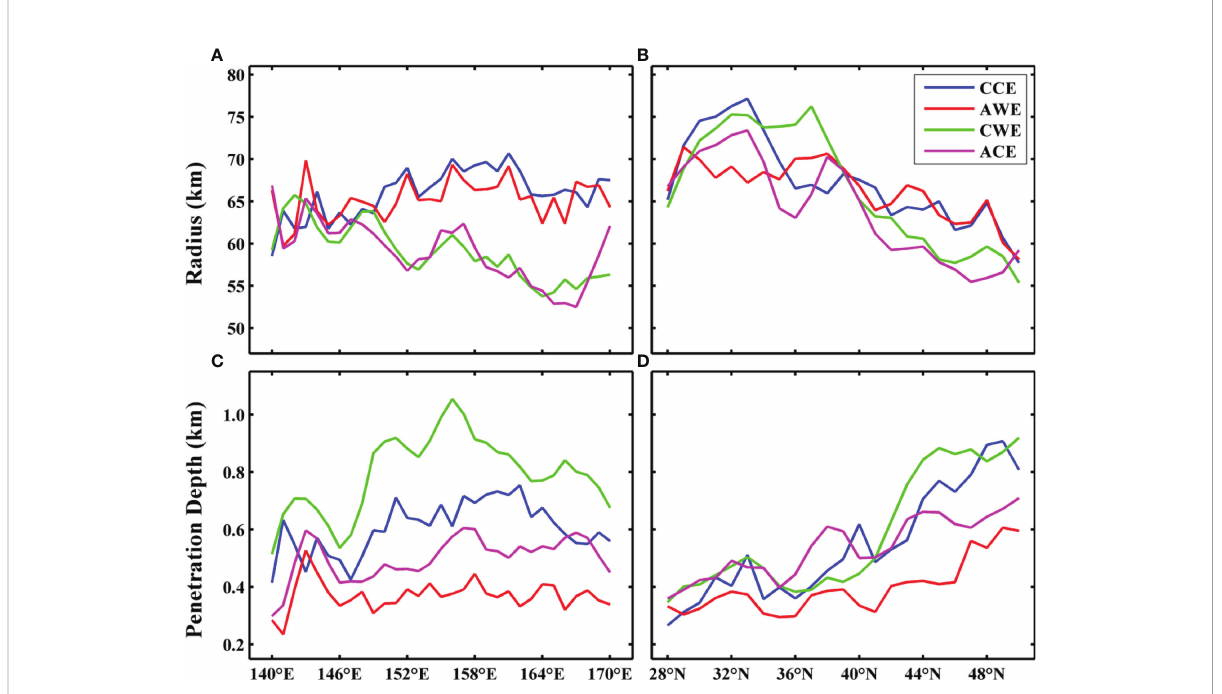
FIGURE 7 Variation of average eddy radius and vertical penetration depth of three-dimensional eddies with (A, C) longitude and (B, D) latitude. The fi gure ’ s blue, red, green, and magenta lines indicate cyclonic cold-core, anticyclonic warm-core, cyclonic warm-core, and anticyclonic cold-core eddies,